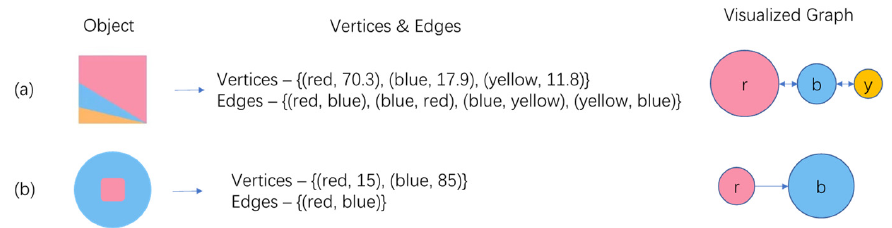
Figure 5. Vertices and edges with geographical information. ( a ) Vertex and edge set for Square with three colors; ( b ) Vertex and edge set for Round with two colors.